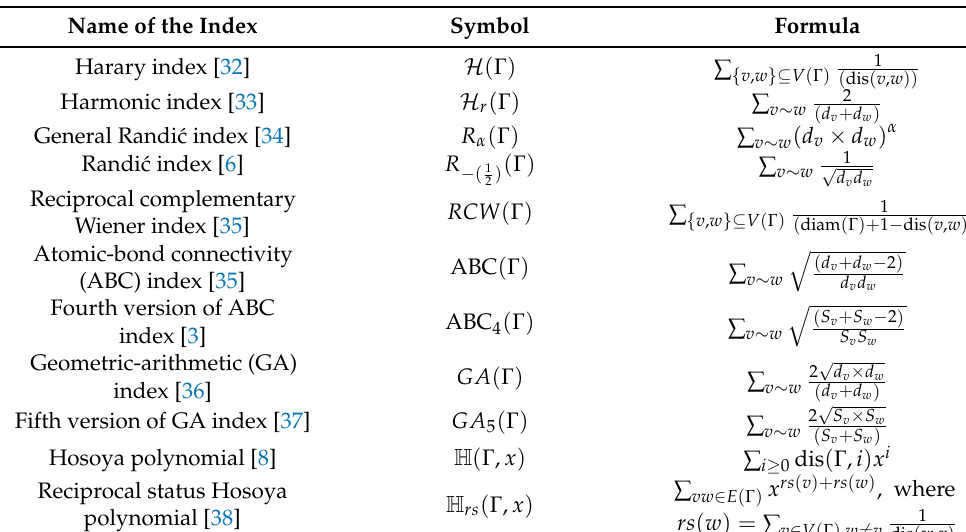
Table 1. The following table contains a list of various topological